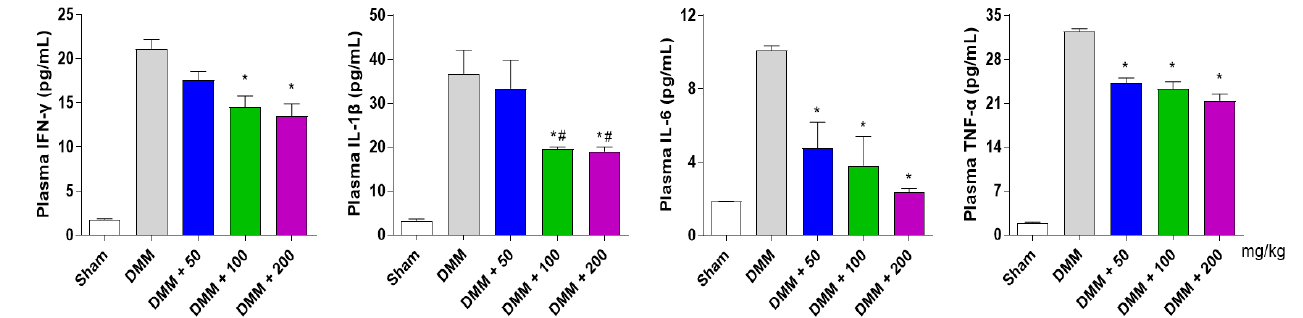
Figure 7. Effect of PG extract on plasma levels of inflammatory cytokines in a DMM-induced OA mouse model. Plasma levels of inflammatory cytokines, such as IFN- γ , IL-1 β , IL-6, and TNF- α , were determined using cytokine/chemokine magnetic bead panel immunology multiplex assay. * p < 0.05 vs. DMM, # p < 0.05 vs. DMM + 50. Sham; non-treated group.